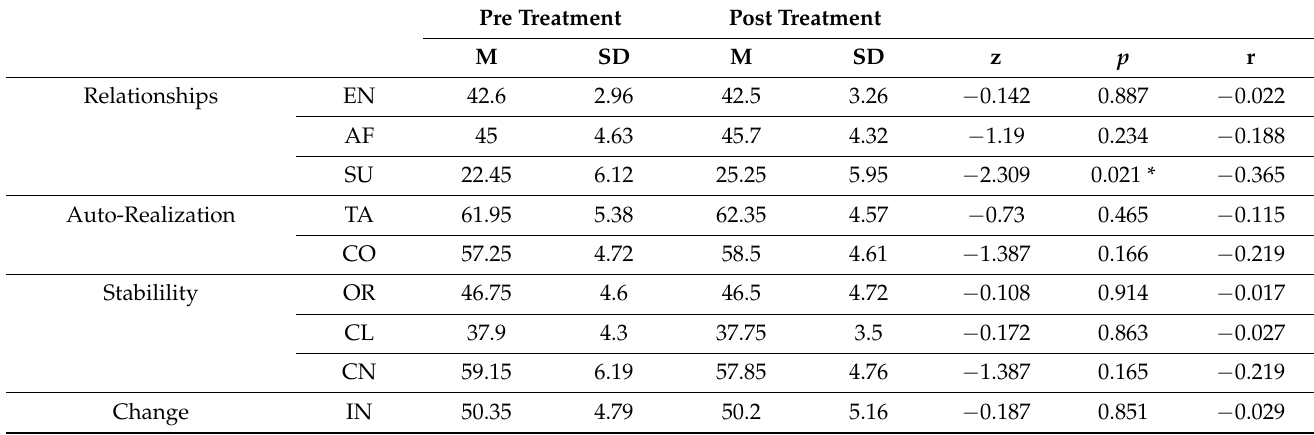
Table 5. Pre-post comparison of the control group. School